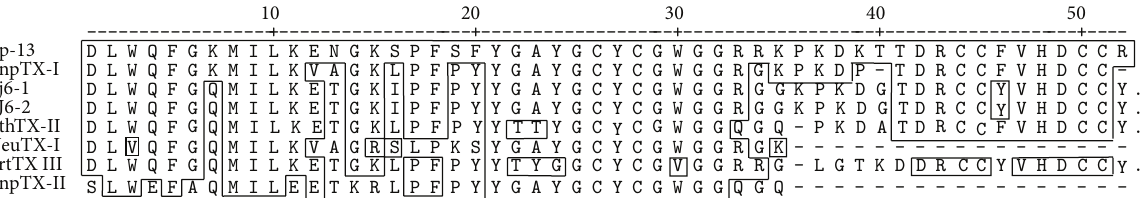
Figure 4: The amino acid sequence N-terminal, alignment of Bp-13 with selected PLA 2 sequences obtained from the BLAST protein data bank (PubMed–Medline). PrtTX III from Bothrops pirajai [55], PLA 2 Bj p from Bothrops jararacussu [30], PLA 2 6-1 and PLA 2 6-2 [22] and BthTx-II, bothropstoxin II, from Bothrops jararacussu [56], BnpTX-I and BnpTX-II [32], and NeuTX-I